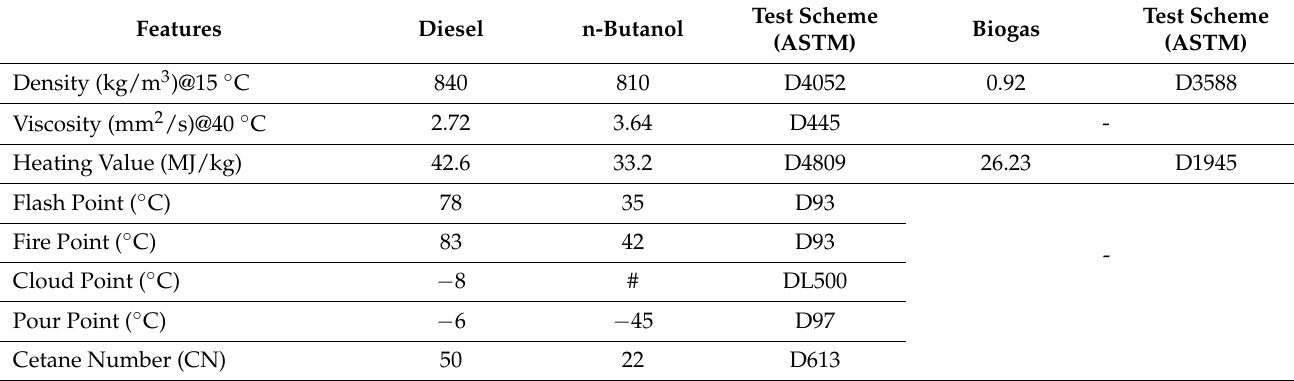
Table 1. Various traits of the test fuel along with its ASTM based test scheme (# Not provided by the supplier). Features Diesel n-Butanol